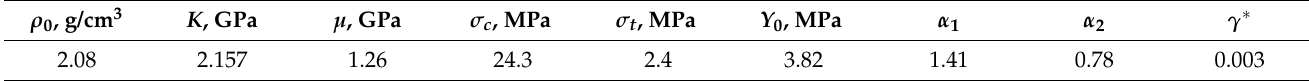
Table 2. The summary of the model